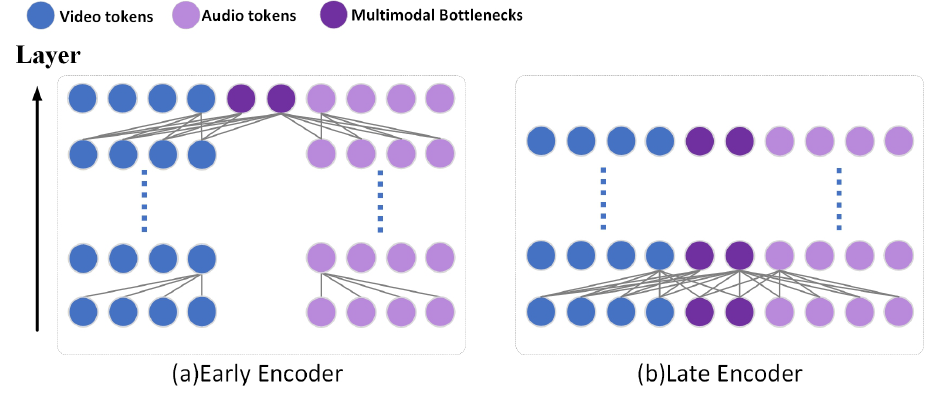
Figure 2. Each layer of tokens in the early encoders ( a ) and later encoders ( b ). Each encoder layer L consists of two sub-layers: a multi-head self-attention and a fully connected network. Layer normal is used to normalize the input of two sub-layers, and the input and output of each sub-layer are residual connected. Therefore, the L -layer encoder layer is defined as